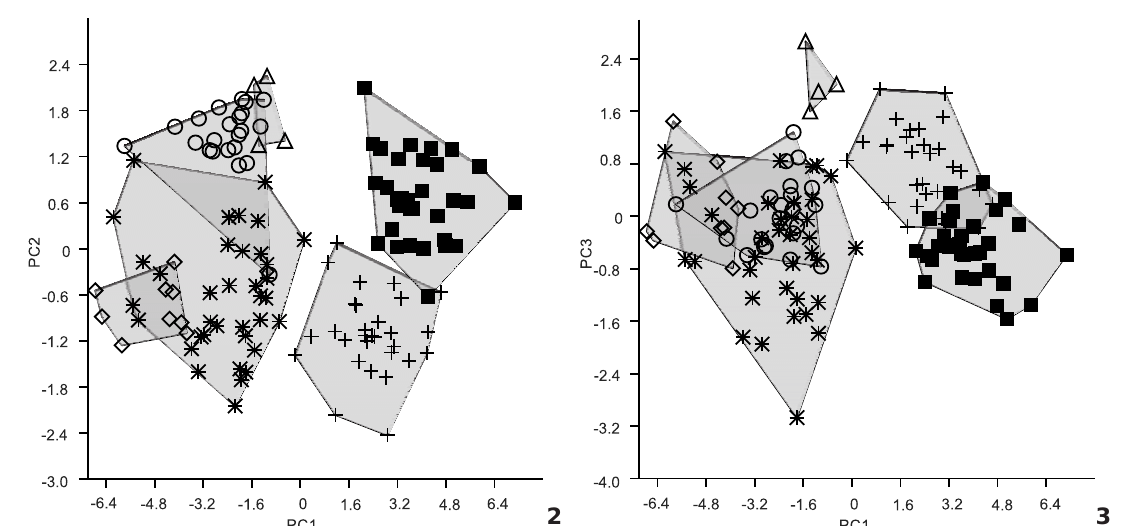
Figures 2-3. PCA scatter plot representing the projection of the six examined taxa ( (cid:132) ) Myotis levis levis , ( (cid:123) ) Myotis levis dinellii , ( (cid:168) ) Myotis ruber , ( (cid:195) ) Myotis nigricans , ( (cid:145) ) Myotis riparius , and ( (cid:83) ) Myotis albescens , in the multivariate space formed by PC1 and PC2 (2) and PC1 and PC3 (3).